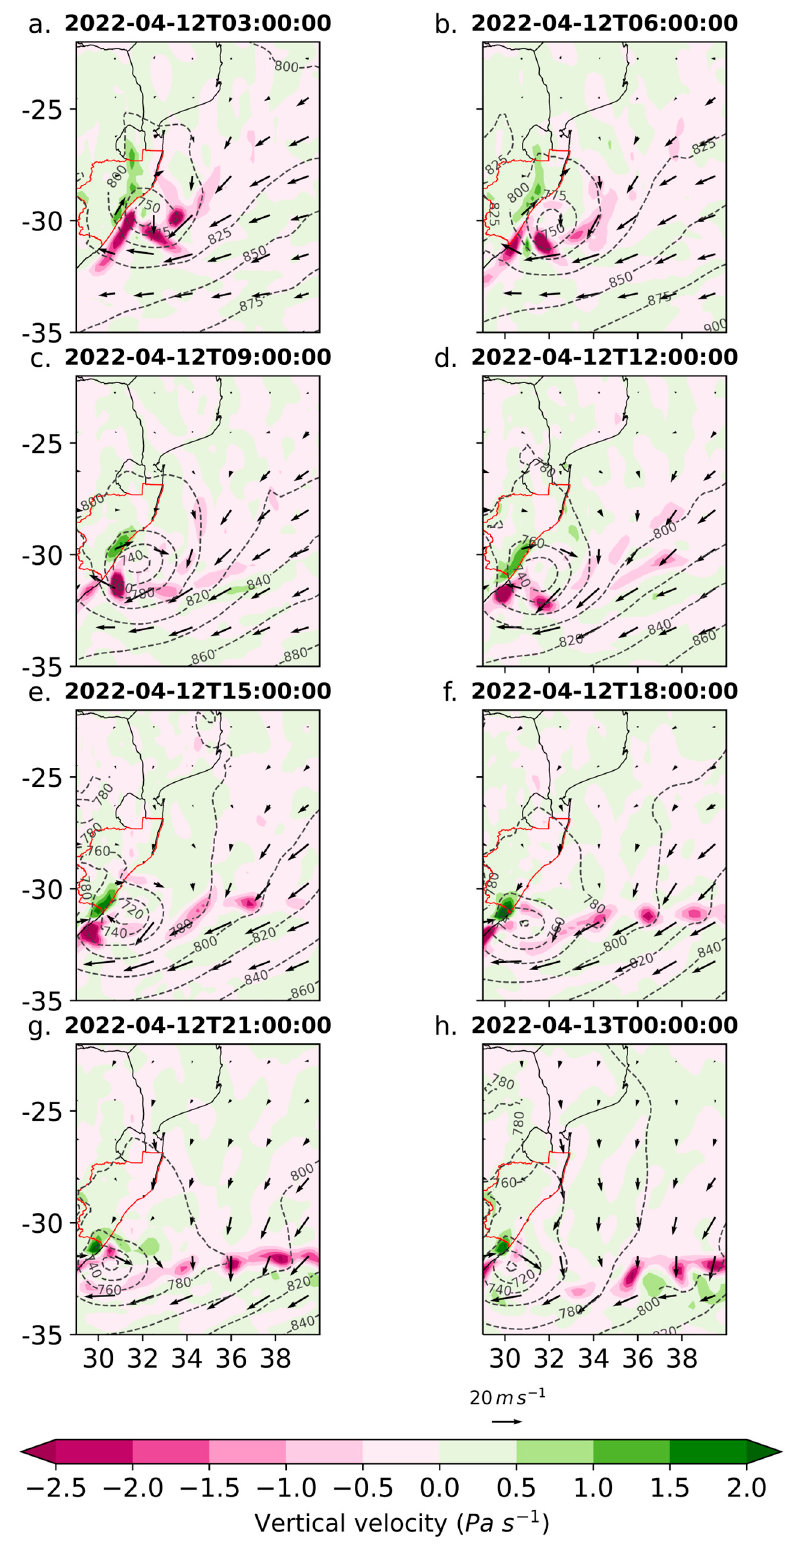
Figure A6. Same as Figure A5, but for vertical velocity (shaded; Pa s − 1 ) and wind speed (vectors; m.s − 1 ) at the 925 hPa pressure level.